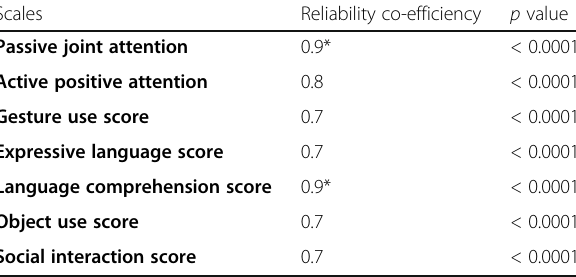
Table 2 The internal consistency reliability of ECSAC Scales